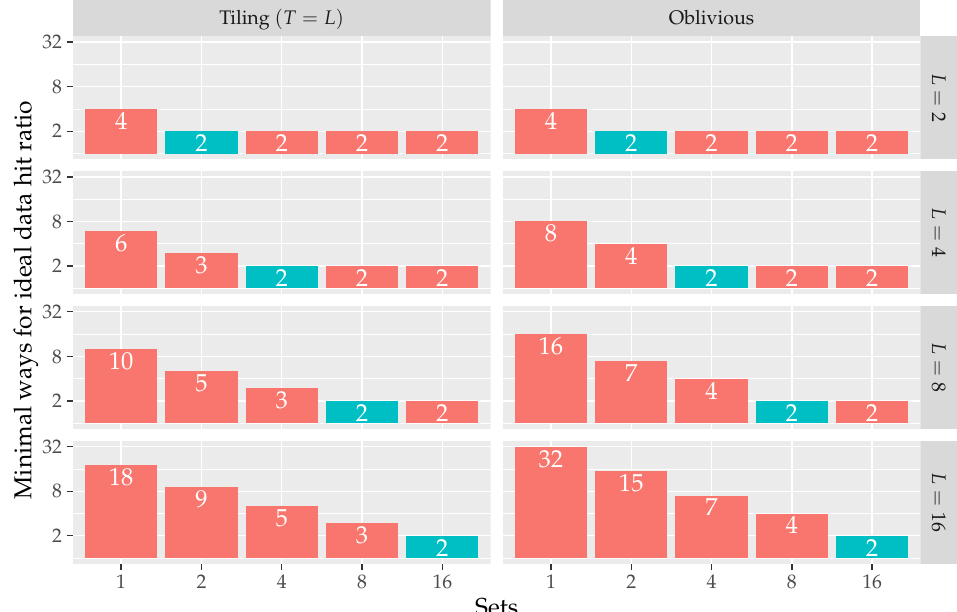
Figure 9. Minimum number of ways ( W ) required to achieve the ideal data hit ratio, depending on the number of cache sets S and line size L , for matrix transposition with a T and for a phantom-padded cache-oblivious algorithm (the lower the better).